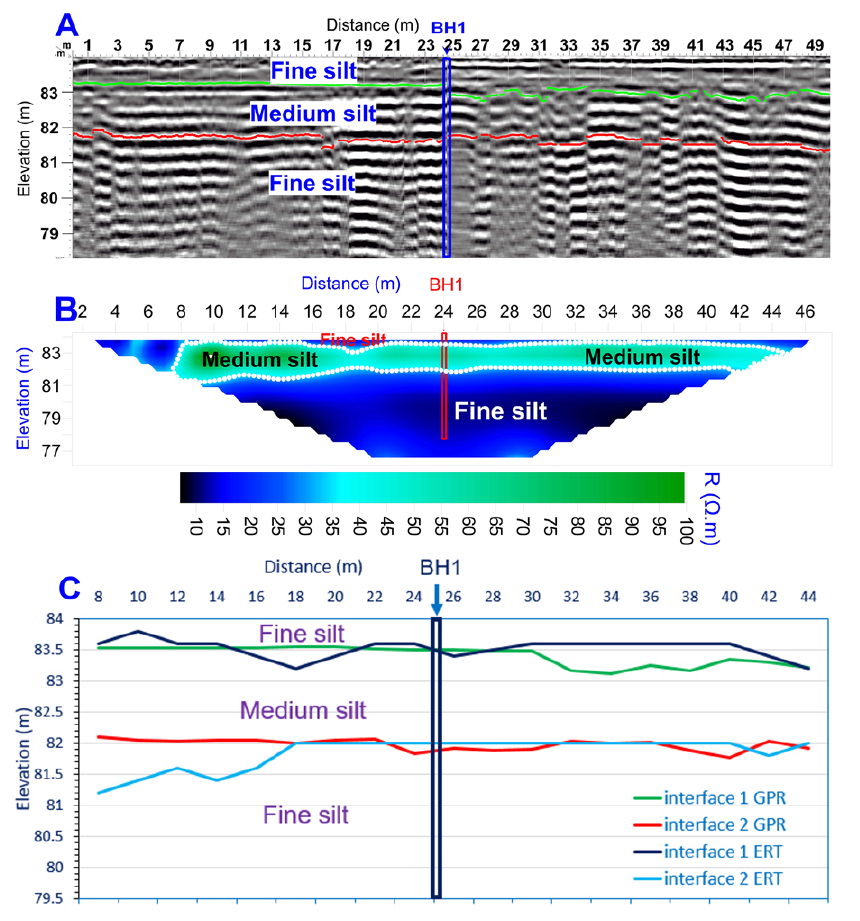
Figure 7. Combination of A) GPR and B) ERT results in the same profile to determine C) the depth of